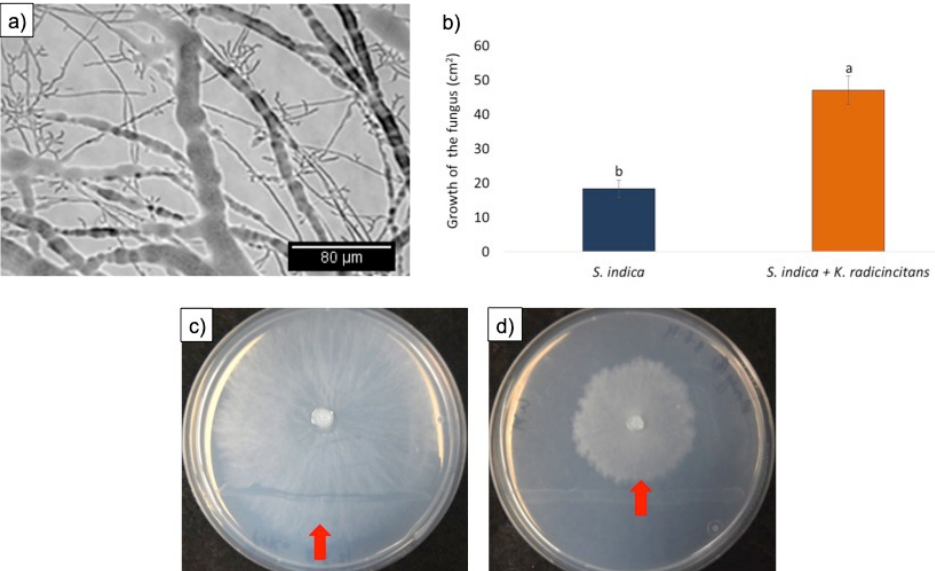
Figure 5. ( a ) K. radicincitans forming a biofilm-like structure on the hyphae of S. indica. ( b ) The area covered by uninoculated S. indica and S. indica – K. radicincitans consortia when confronted with the fungus-feeding bacterium C. fungivorans. ( c ) A Petri dish showing the growth of S. indica–K. radicincitans consortia (red arrow) when confronted with C. fungivorans. ( d ) Growth of uninoculated S. indica (red arrow) when confronted with C. fungivorans . Different letters above bars represent significant differences ( p < 0.05) according to one-way ANOVA followed by a Tukey’s range test. Error bars indicate the standard deviation of means of six different replicates.